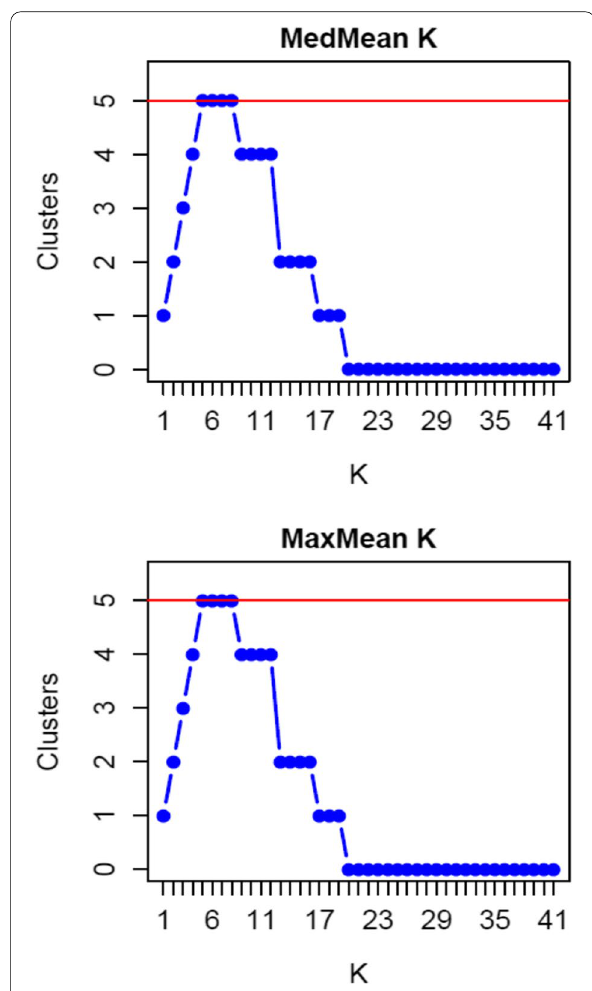
Fig. 2 The optimal K number indicated by alternative measures MedMean K and MaxMean K applied in STRU CTU RE